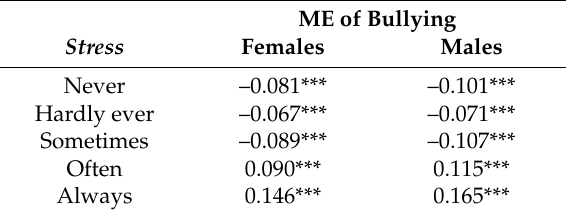
Table A4. Estimated marginal effect of bullying on work-related stress—females and males.